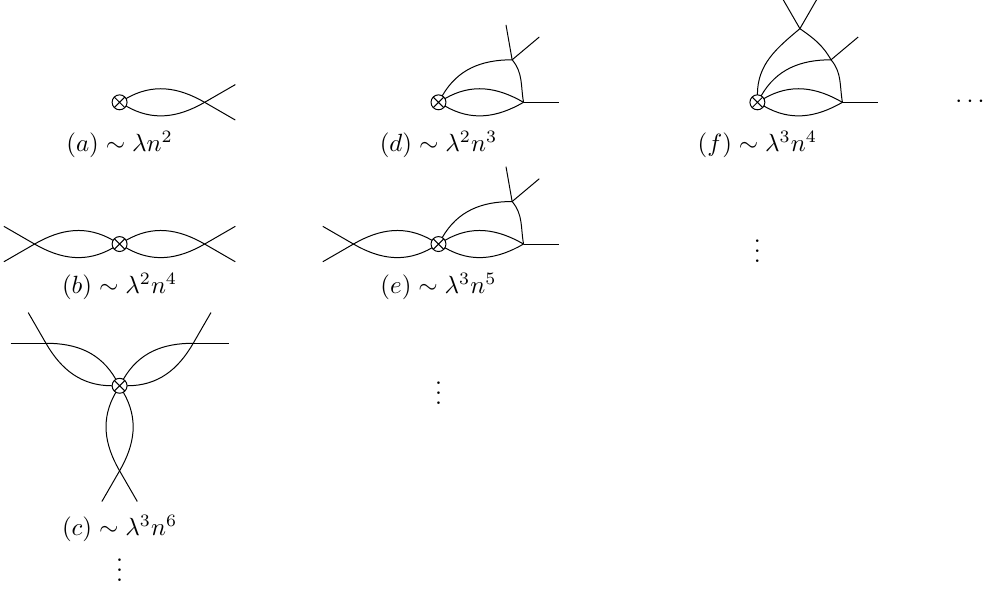
Figure 1. Some characteristic Feynman diagrams that appear with the (cid:30) n